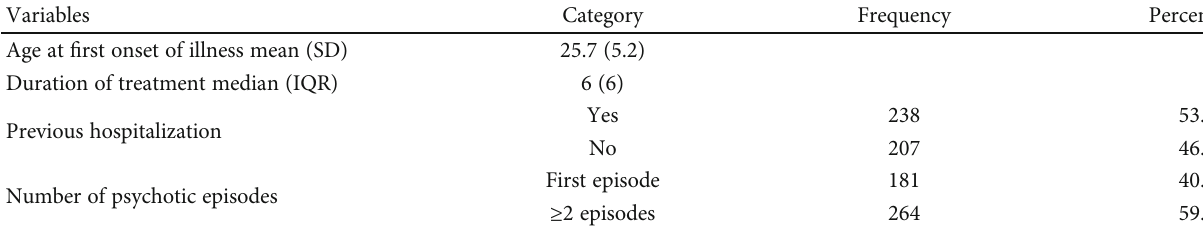
Table 2: Description of the clinical characteristic of the patients with schizophrenia in AMSH 2018.